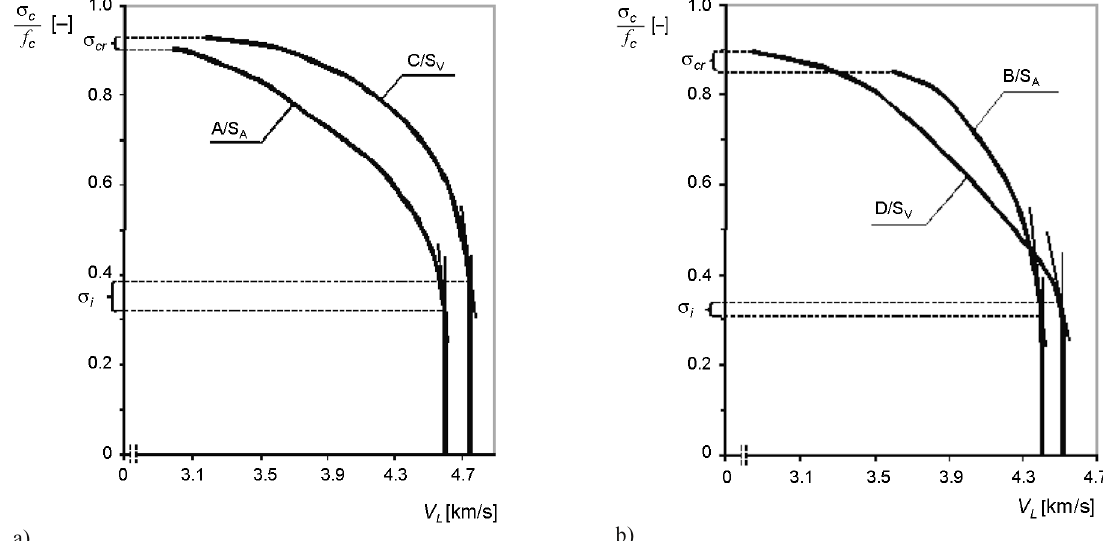
Fig. 7. Longitudinal ultrasonic wave velocity versus relative compressive stress in concretes: a) A/S A and C/S V ; b) B/S A and D/S